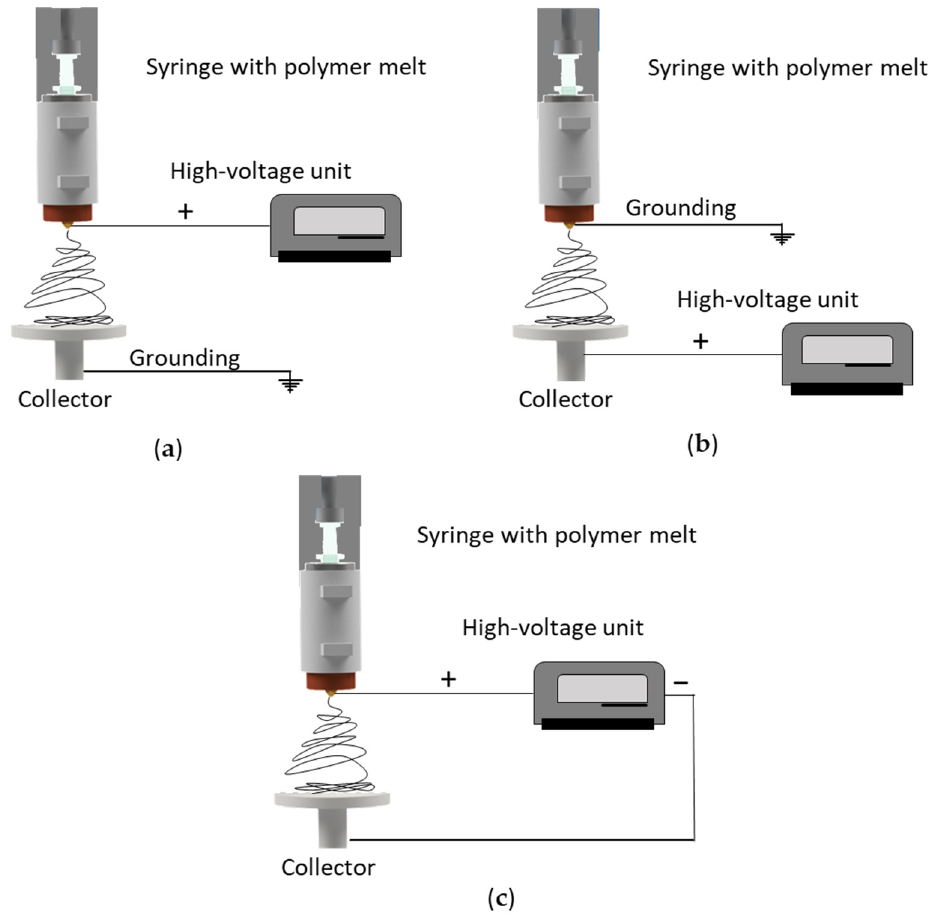
Figure 1. Typical current electrospinning setups. ( a ) Syringe charged and collector grounded. ( b ) Syringe grounded and collector charged. ( c ) Both syringe and collector charged.